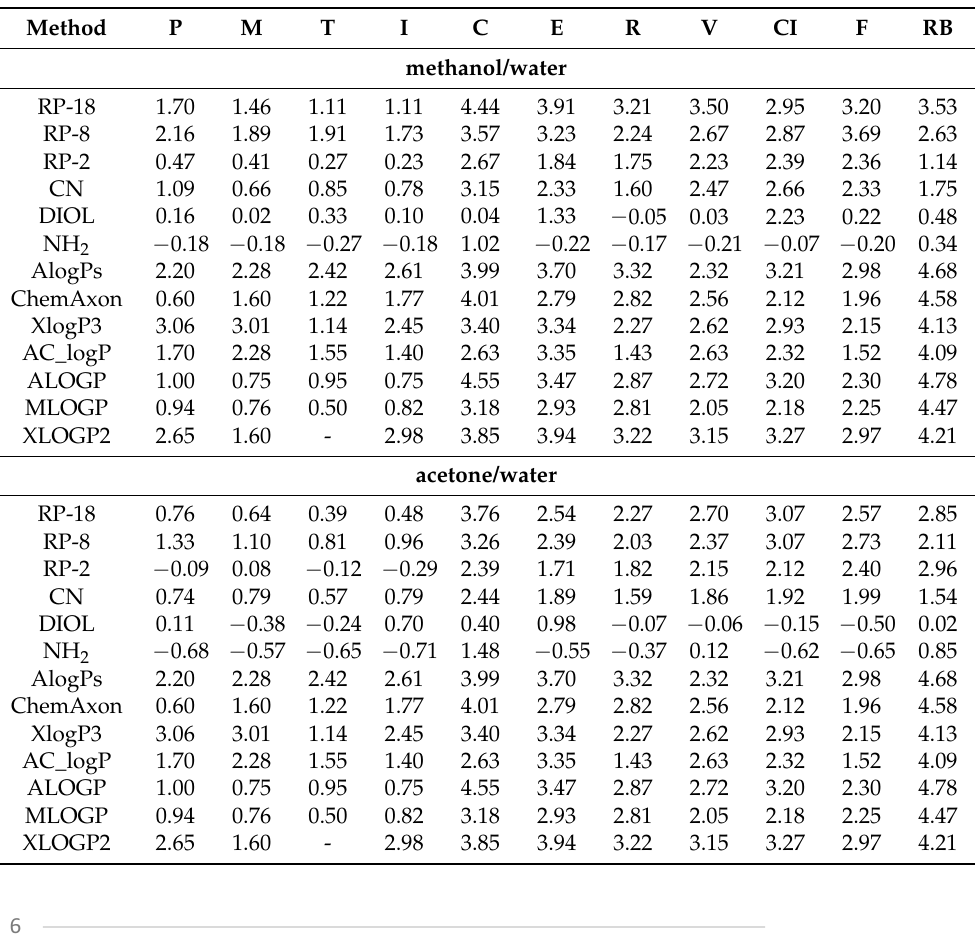
Table 2. The R M0 values for the tested compounds obtained experimentally and with the use of calculation methods.